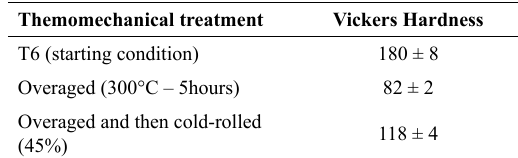
Table 2. Vickers hardness measures of AA 7075 at different